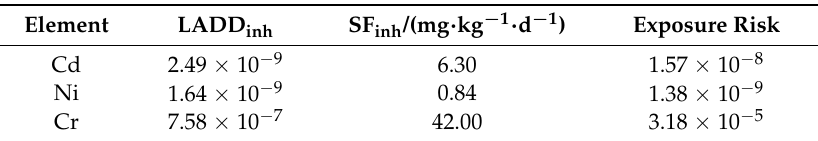
Table 8. Carcinogenic risk values of heavy metal in inhalation exposure pathway in Leisure Squares of Yanta District in Xi’an.